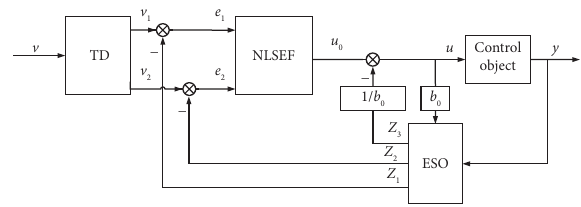
Figure 9: Principle diagram of the ADRC